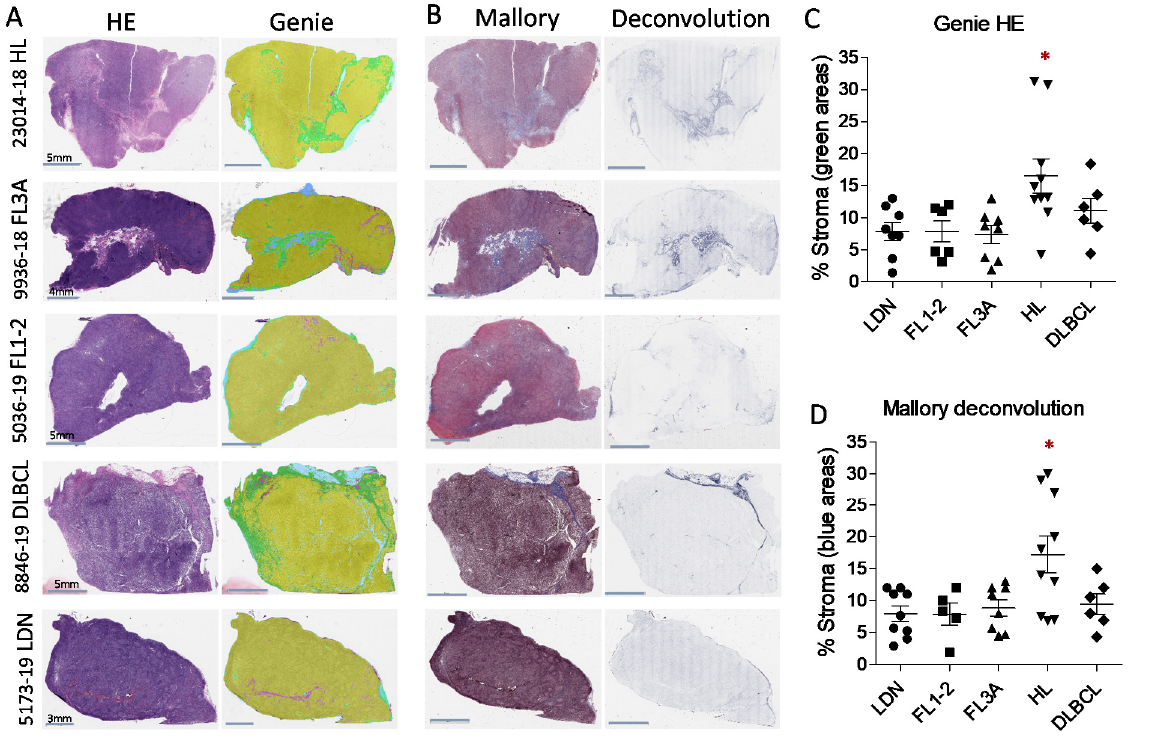
Figure 1. Digital pathology imaging and measurement of lymph node stroma in HL and NHL. Slides of hematoxilin-eosin (HE, representative cases in Panel ( A )) or Mallory trichrome staining (representative cases in Panel ( B )) from LN sections of patients with HL ( n = 11), FL1-2 ( n = 6), FL3A ( n = 8), DLBCL ( n = 6), compared with 9 LDN, were subjected to Digital Pathology Imaging. Panel ( C ). HE sections were analyzed with the Genie software (right images in Panel ( A )) and the percentage area of stromal compartment per slide was calculated, adjusted to total tissue area in the image analyzed. Data are expressed as a percentage of green pseudocolor (stromal) areas and are the mean ± SEM of the indicated number of cases for each histological type. * p < 0.05 vs. LDN, FL1-2 and FL3A. Panel ( D ): digital images of Mallory trichrome stained sections were analyzed with an automated image analysis algorithm for color deconvolution (right images in Panel ( B )) and collagen areas quantified by the Image Scope software. Data are expressed as percentage of blue (collagen) areas and are the mean ± SEM of the indicated number of cases for each histological type. * p < 0.005 vs. LDN, FL1-2 and FL3A.